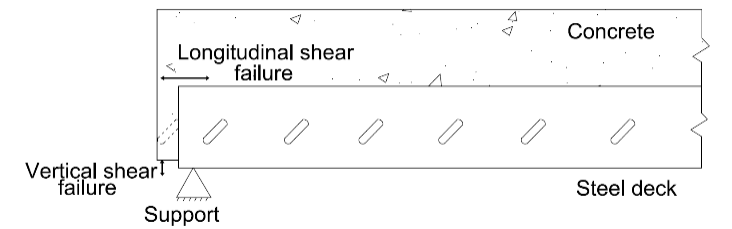
Figure 2. Failure modes in composite slabs.